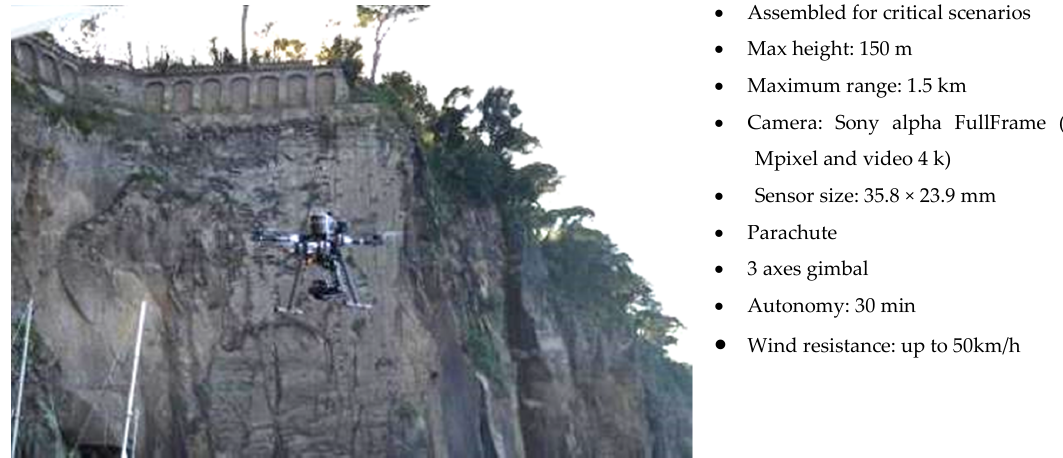
Figure 2. Main features of the Italdron 4HSEPRO.